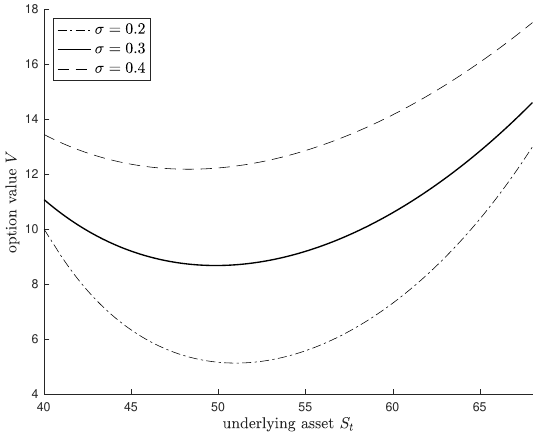
Figure 5. The option values at time t = 0 with respect to σ .